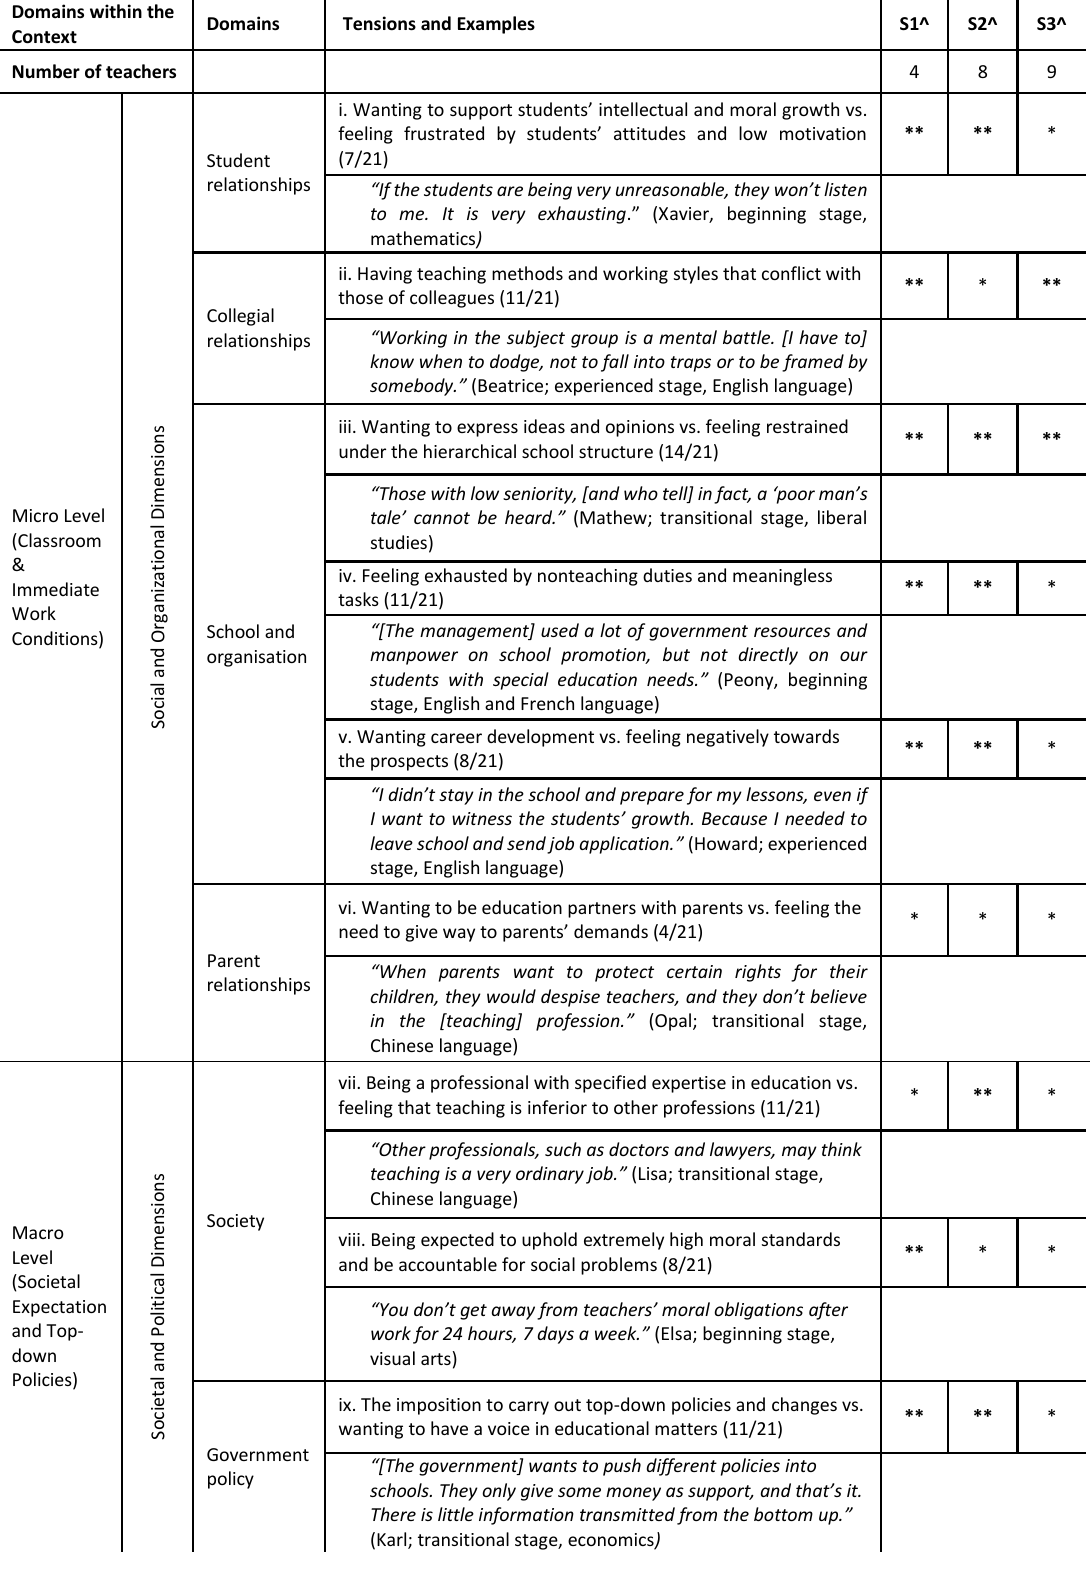
Table 2. Findings on teacher identity tension Domains within the Context